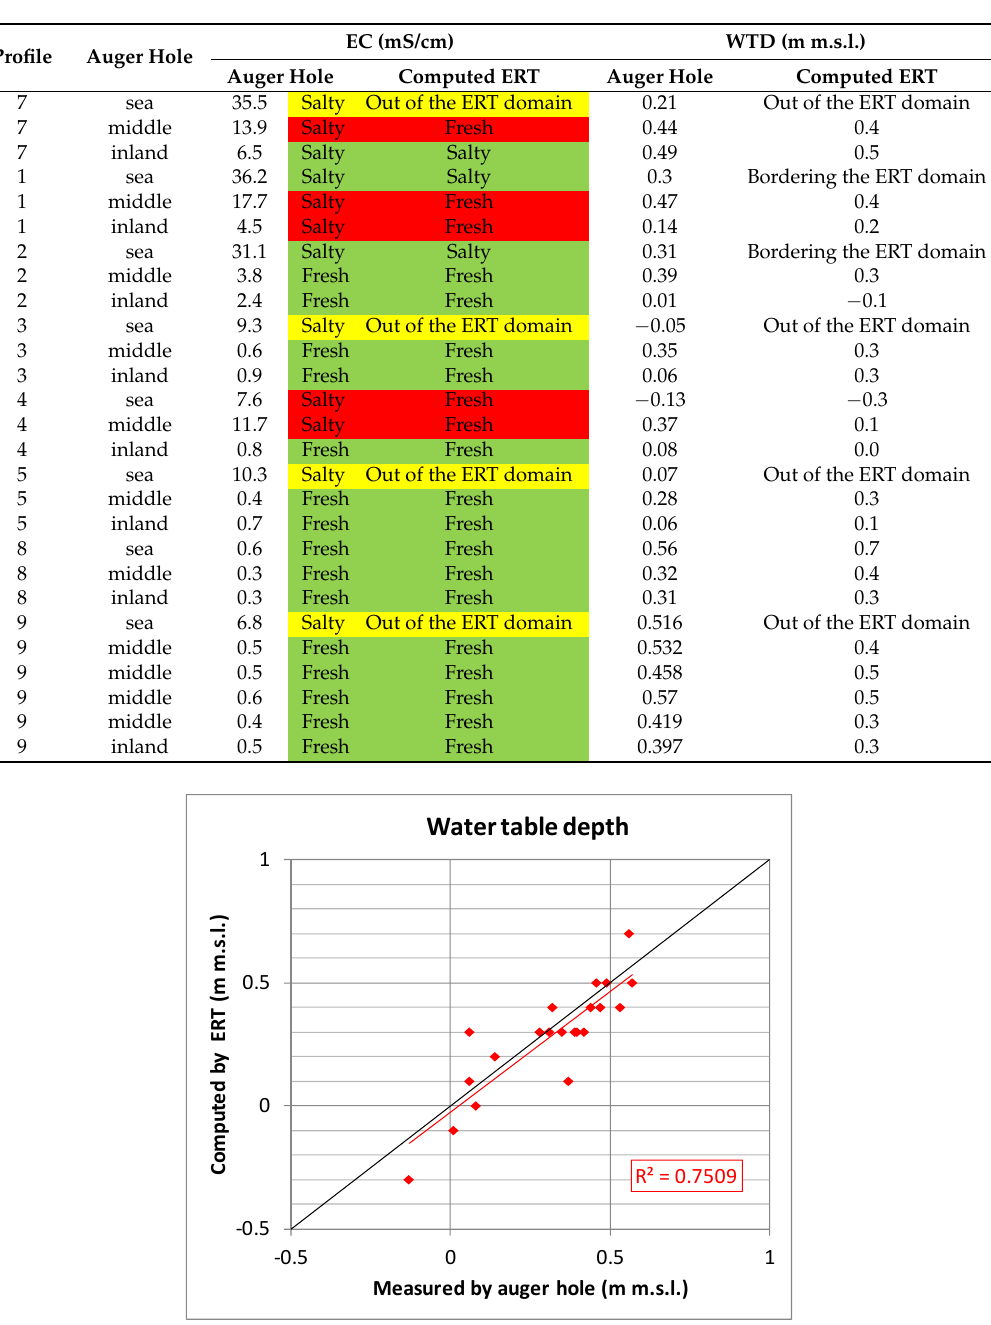
Figure 8. Scatter plot diagram between measured WTD (by auger holes) and computed data (by ERT inversion).